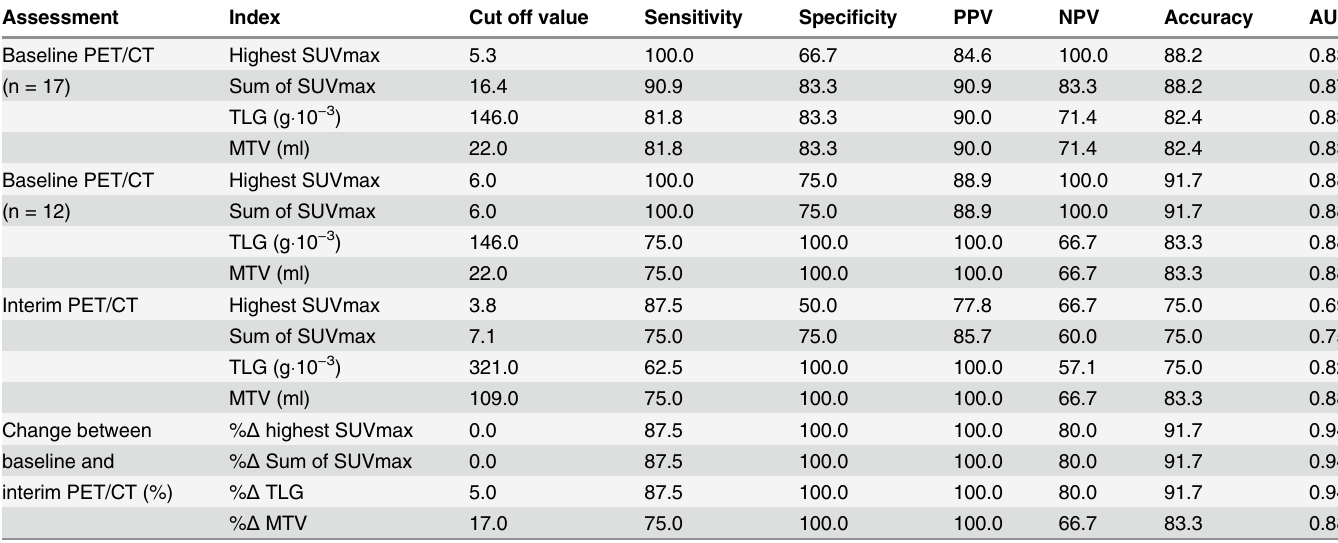
calculated because of inadequate sample size (p > 0.08). The NPV of interim PET/CT for pre- dicting PFS at 12 months (range 57.1 – 66.7%) was lower than the other indexes. The change between baseline and interim PET/CT showed the highest PPV (100.0%) for predicting disease progression at 12 months (Figs 1 and 2). Table 3. Results Based on ROC Analysis for Predicting Progression Free Survival at 12 Months.